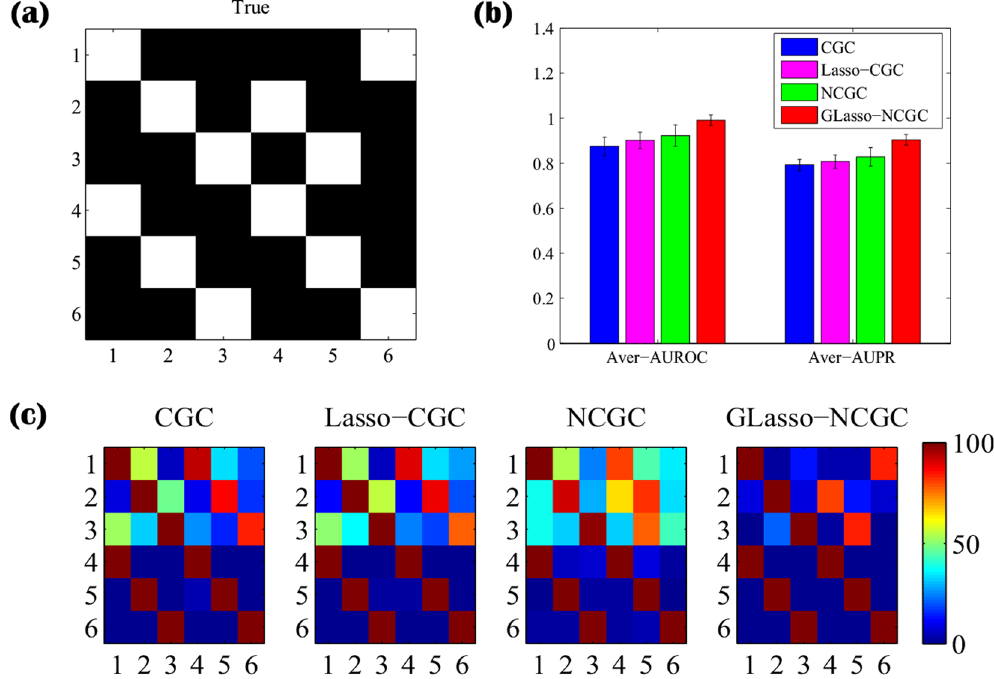
Figure 6. Simulation of BRN. The number of multi-realizations is set as 100. ( a ) True network. ( b ) Average AUROC and Average AUPR with standard deviation over multi-realizations. ( c ) Discovery rate matrixes inferred from multi-realizations.